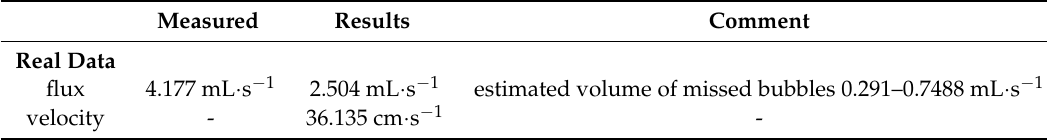
Table 2. Results on real data image